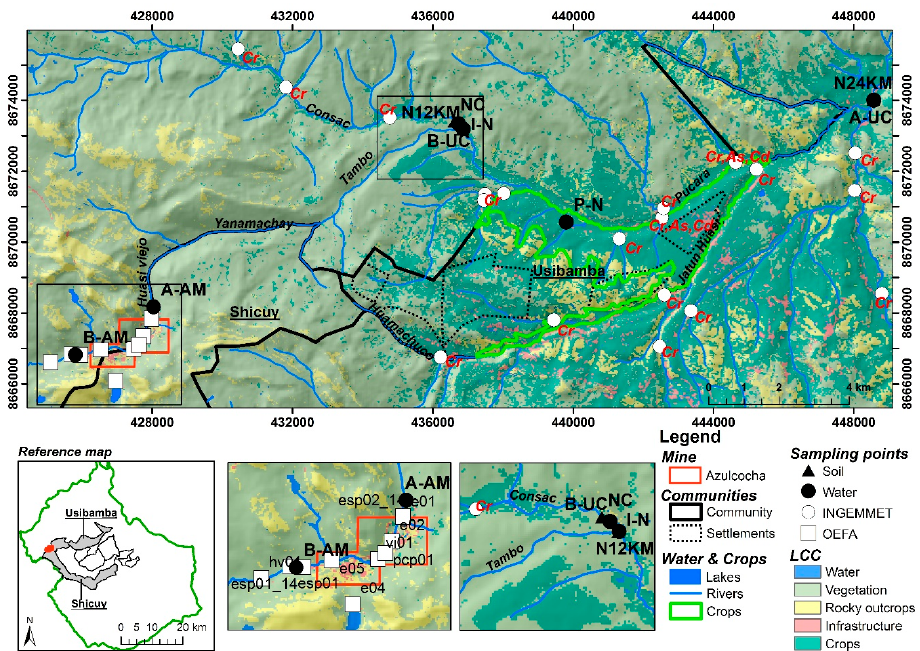
Figure 6. Land-cover classification and participatory mapping in Usibamba community. OEFA refers to the location of the samples collected by the OEFA in 2013. The locations of geochemistry values reported in 2014–2016 by the INGEMMET are indicated by white dots ( ○ ) with the relevant presence of heavy metals. In the case of As and Cd, they had higher concentrations than EQS. The locations of our water and soil results are referred to as water ( ● ) and soil ( ▲ ). The Usibamba settlements are delineated by dotted lines. This figure is based on the participatory mapping, official community maps, INGEMMET [73], and OEFA reports [95].